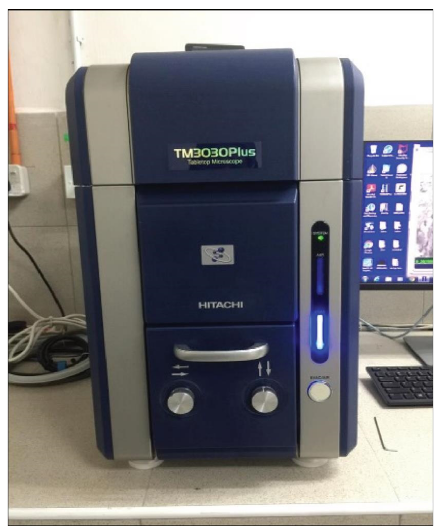
Figure 5: Scanning electron microscope.